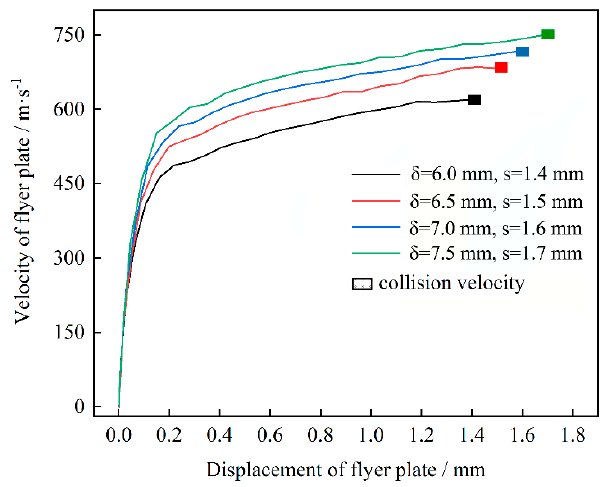
Figure 2. Velocity curves of gauge in the motion process.